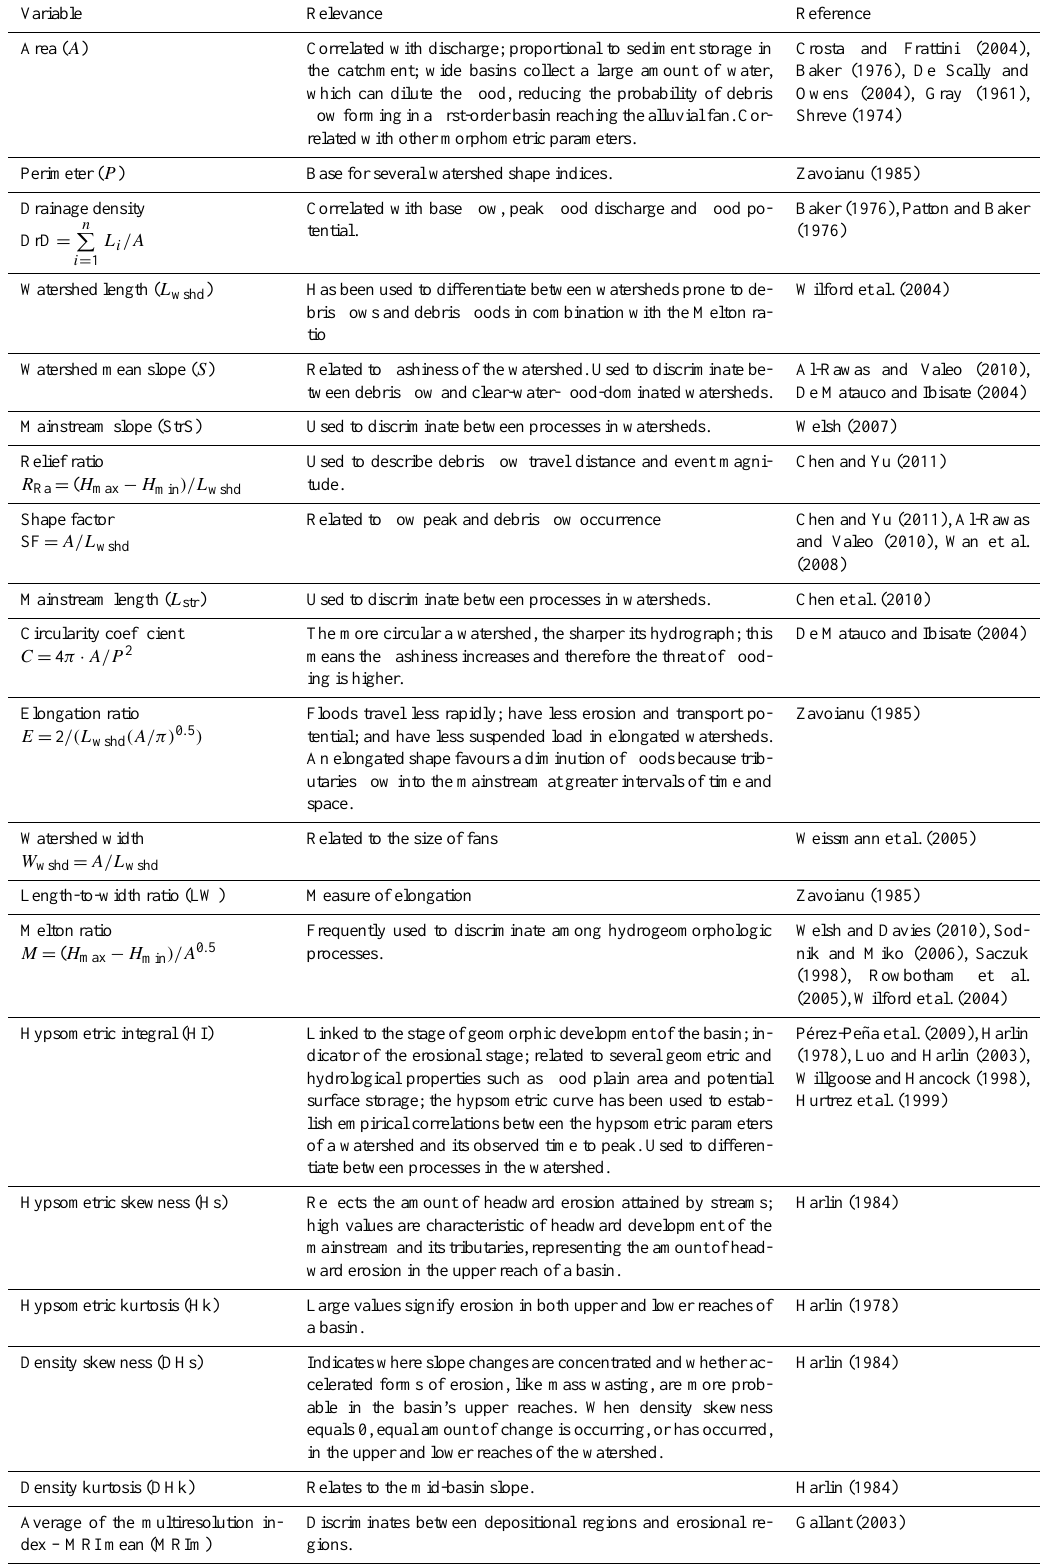
Table 1. Morphometric variables used in the analysis. Note that L corresponds to the length of the streams in a watershed; H max and H min correspond to the highest and lowest elevation in a watershed